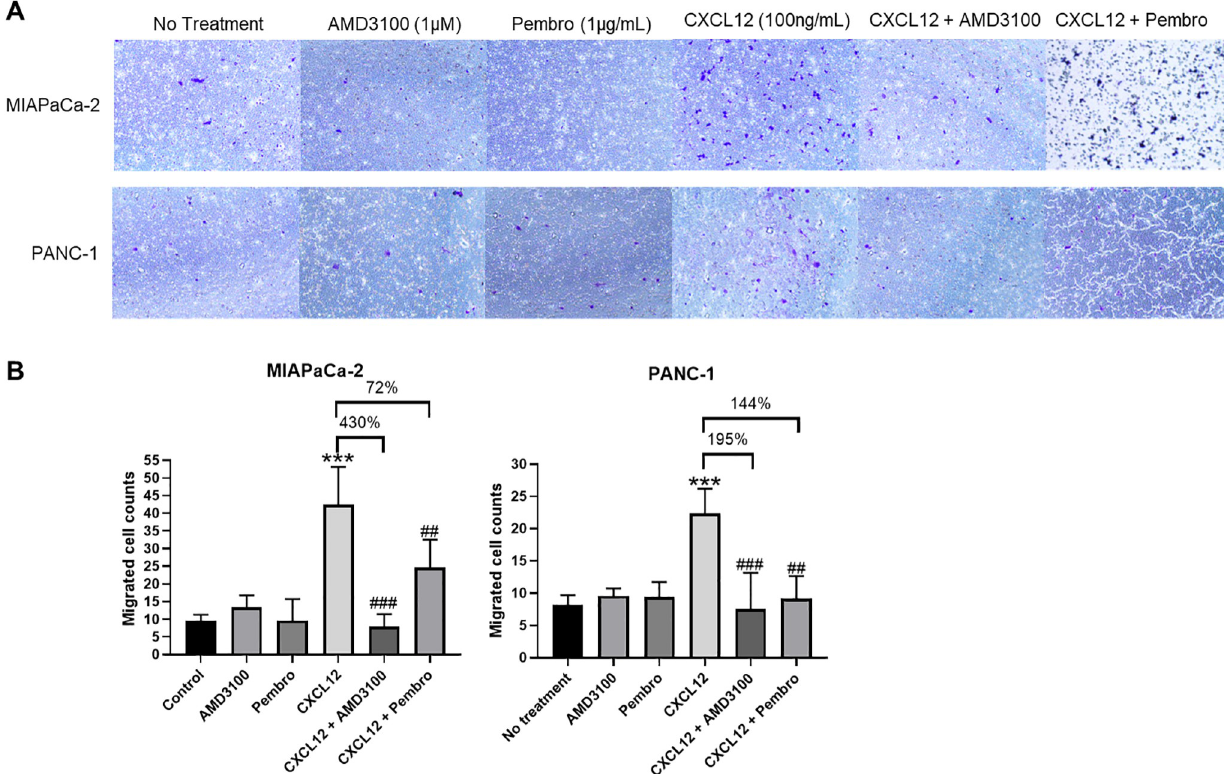
Fig 5. Transwell migration assays of PANC-1 and MIAPaCa-2 cells. ( A ) Treatment with AMD3100 or pembrolizumab alone did not alter cell migration. However, exposure to CXCL12 promoted cell migration in both lines as expected. The addition of AMD3100 or pembrolizumab to CXCL12-treated cells resulted in inhibition of cell migration in both cell lines, demonstrating that inhibition of PD-1 or CXCR4 can block CXCL12-induced migration. All images at 10x magnification. ( B ) Quantification of transwell migration assays revealed that migration was significantly inhibited in CXCL12-treated cells when exposed to AMD3100 and pembrolizumab, demonstrating that combined CXCR4 and PD-1 inhibition abrogated CXCL12-induced migration. ��� p < 0.001 vs. control; ##p < 0.01, ###p < 0.001 vs. CXCL12.